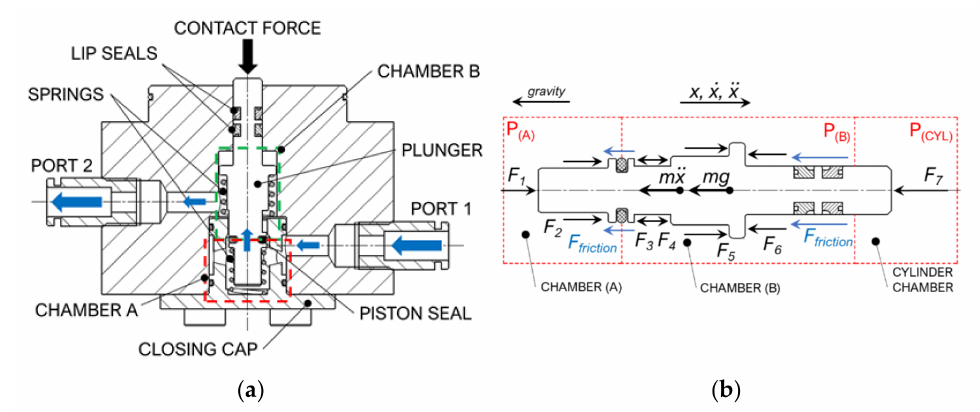
Figure 5. The limit switch system: ( a ) whole system; ( b ) free body diagram of the plunger. In both limit switches, F 3 and F 4 were self-balancing: they were equal and